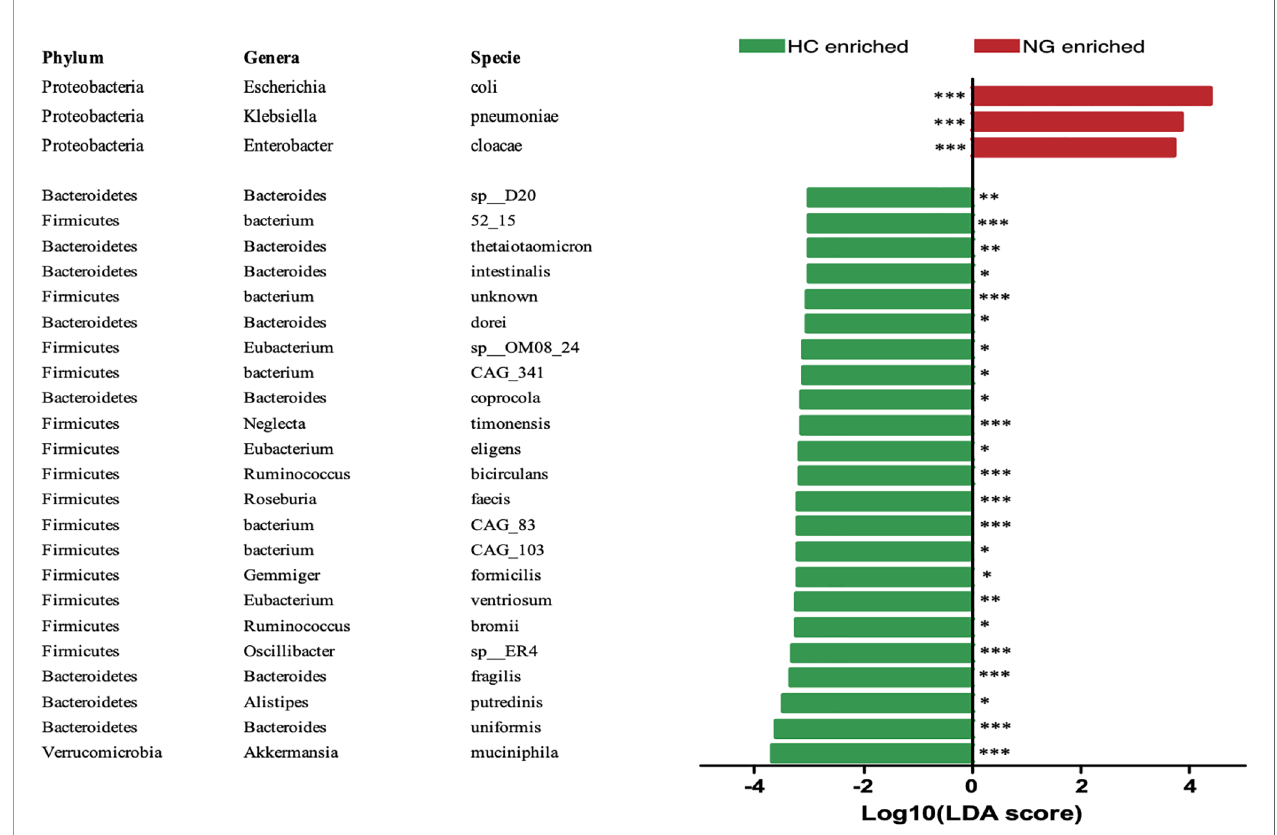
FIGURE 2 | LEfSe analysis showed that the relative abundances of 26 species were signi fi cantly distinct between the two groups. *P < 0.05; **P < 0.01; ***P < 0.001. The Wilcoxon test was performed for comparisons between the two groups. HC, healthy controls; NG, NAFLD group; LEfSe, linear discriminant analysis (LDA) effect size method